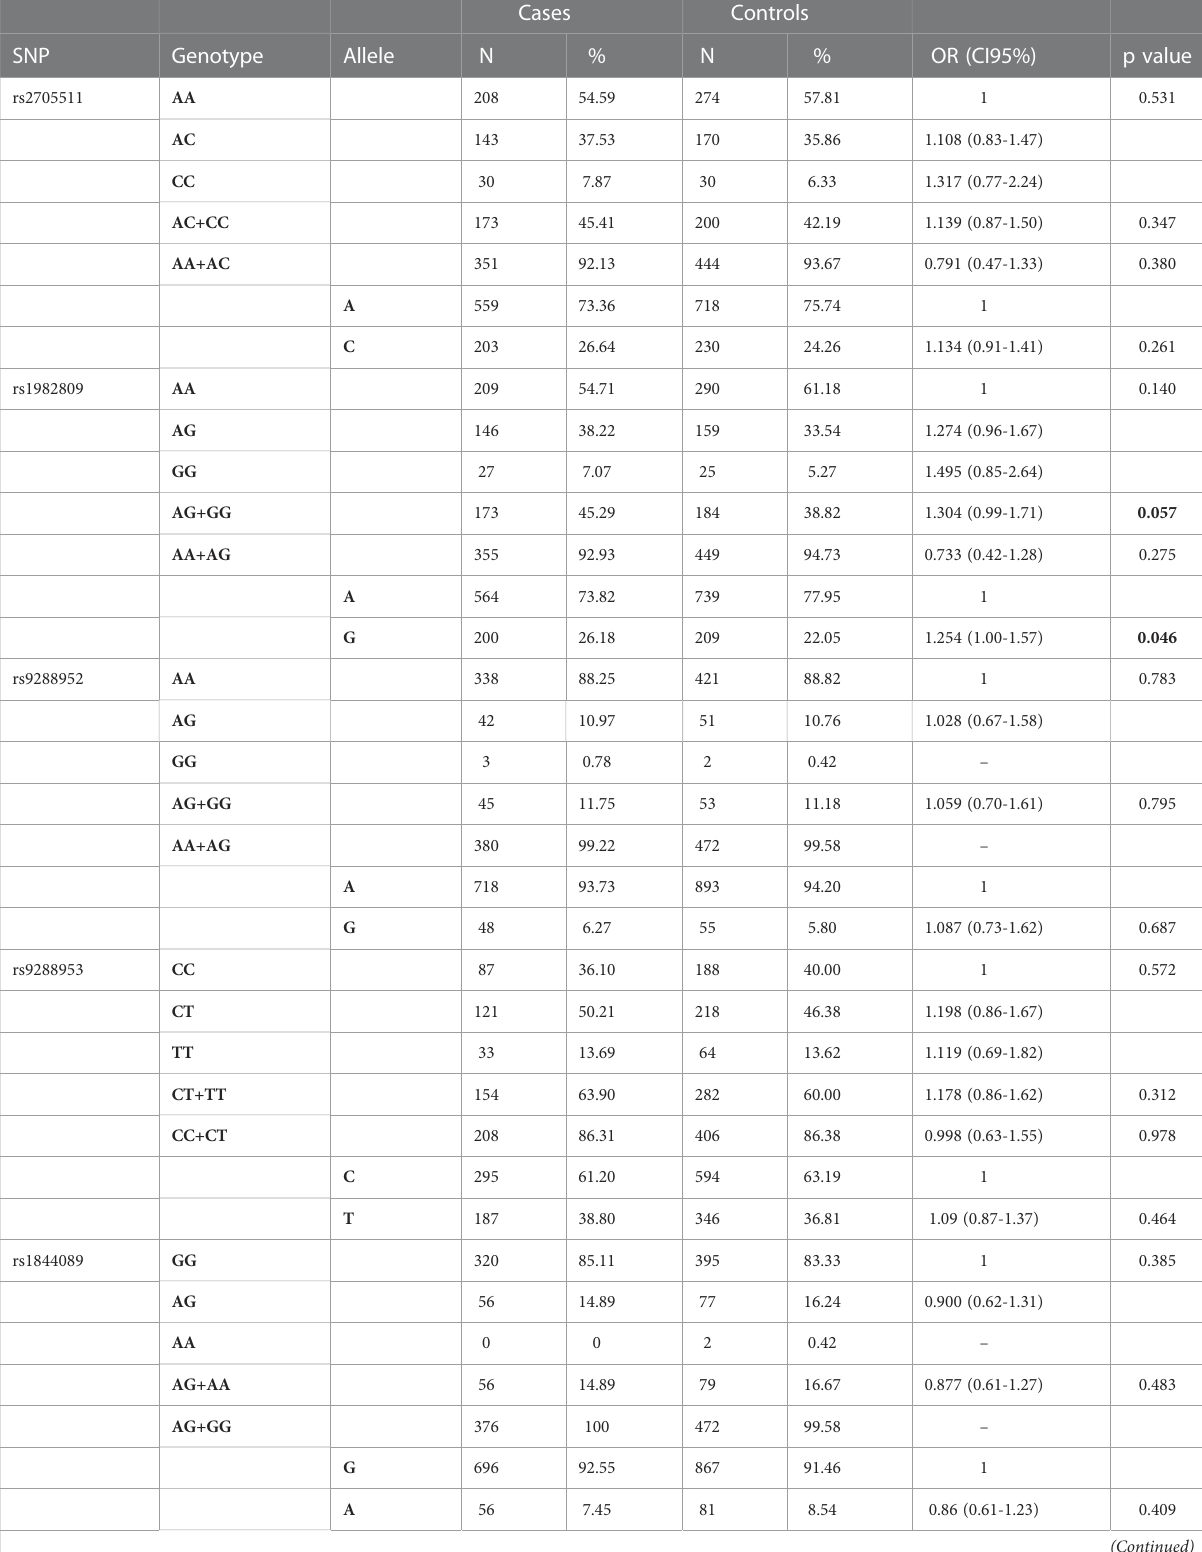
TABLE 2 Genotypes and alleles distribution of BTLA SNPs among NSCLC patients and controls. Cases Controls SNP Genotype Allele N OR (CI95%) p